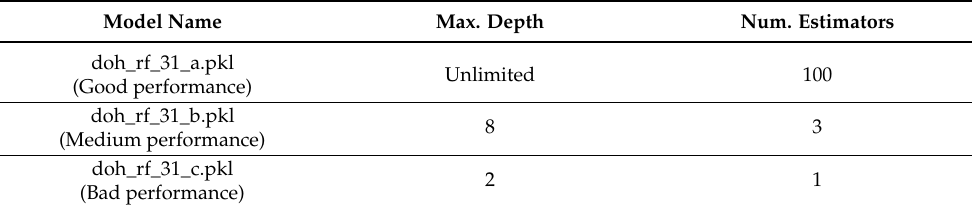
Table 5. Hyperparameters for each DoH Random Forest Classifier model